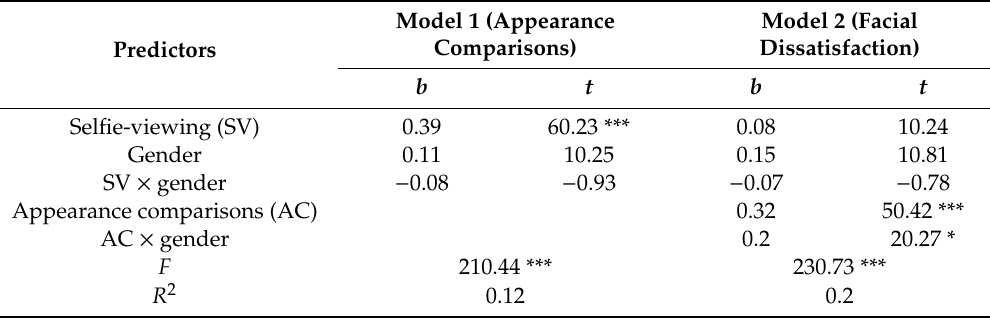
Table 5. Testing the moderating role of gender in the mediation